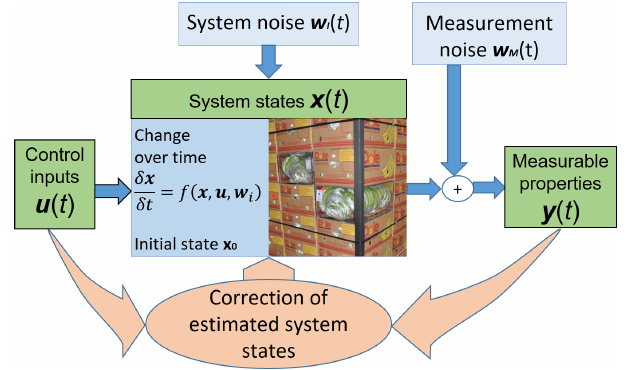
Figure 1. System description in state-space form and principle of state